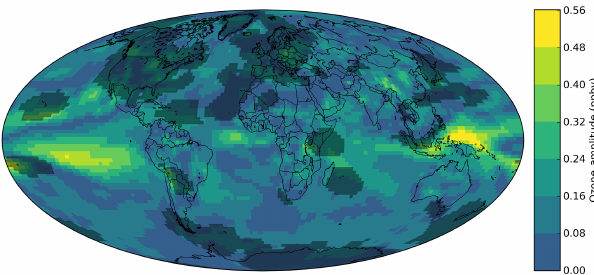
Figure 5. Amplitude of variability (from a spectral/Fourier analy- sis) in surface ozone at the periodicity of ENSO (1403 days) in a free-running simulation using the GFDL chemistry–climate model.